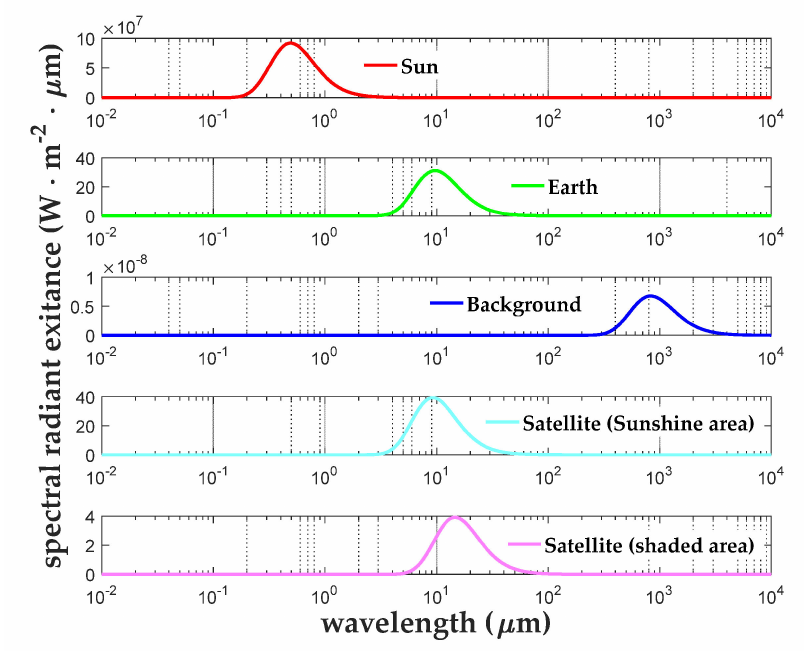
Figure 1. Radiation emission of various radiation sources of space